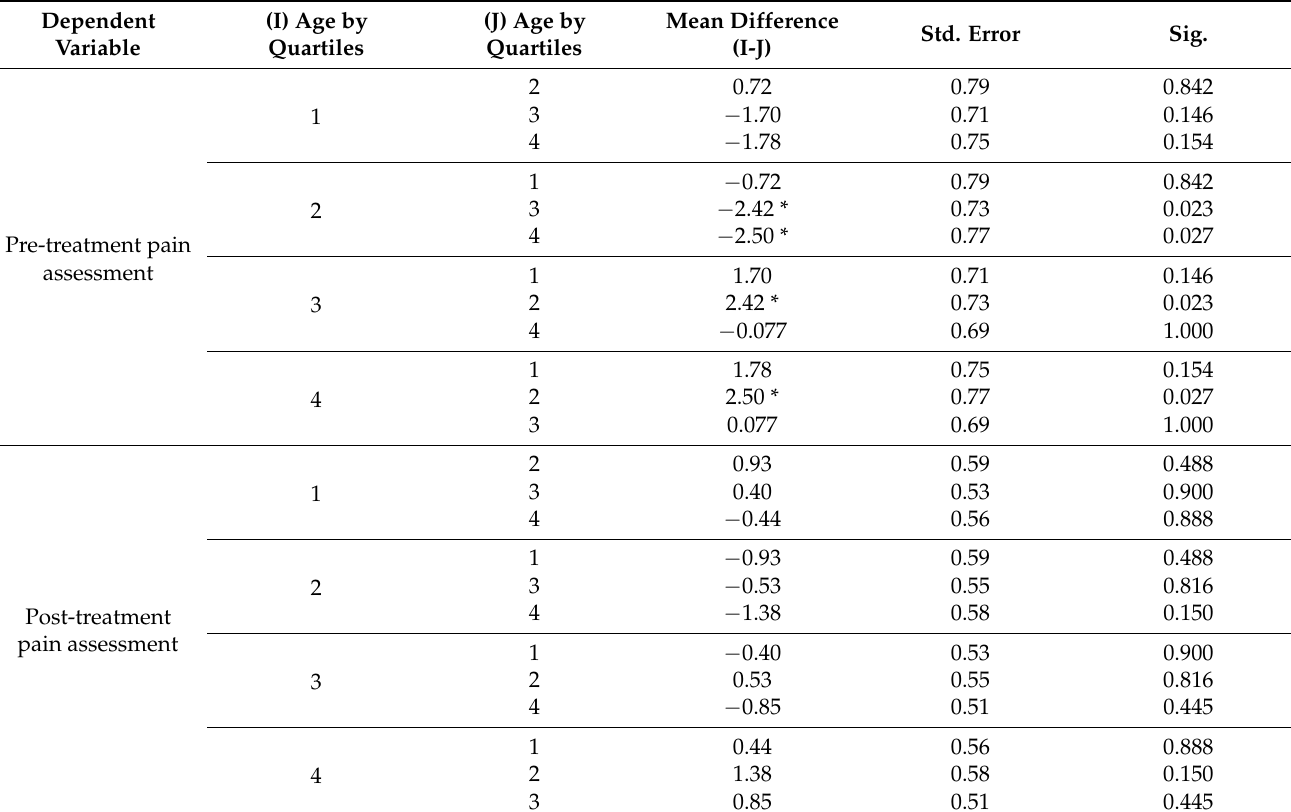
Table 4. Multiple comparisons using Scheffe’s method for